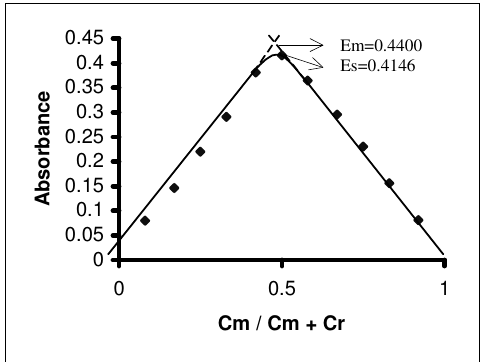
Figure 2. Job’s Method for V(V)-HnPBAO Complex. Plot of Job’s method of continuous variation for determination of M:L ratio